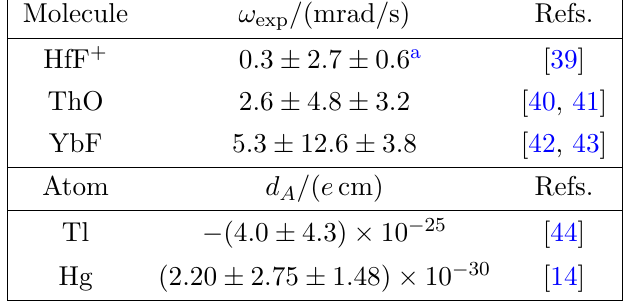
Table 3 . Experimental limits for the systems entering the global